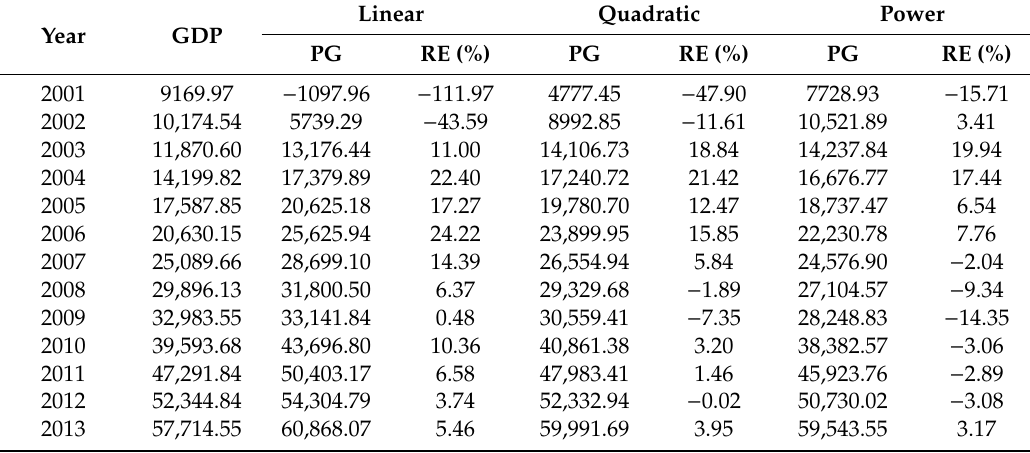
Table 1. Accuracy of the estimated statistical gross domestic product (GDP) on time series at the national scale through the three regression models. Note: GDP represents the statistical gross domestic product, PG represents the predicted GDP, RE represents the relative error in percentage, and MARE represents the mean absolute relative error in percentage. The unit of the GDP is billion